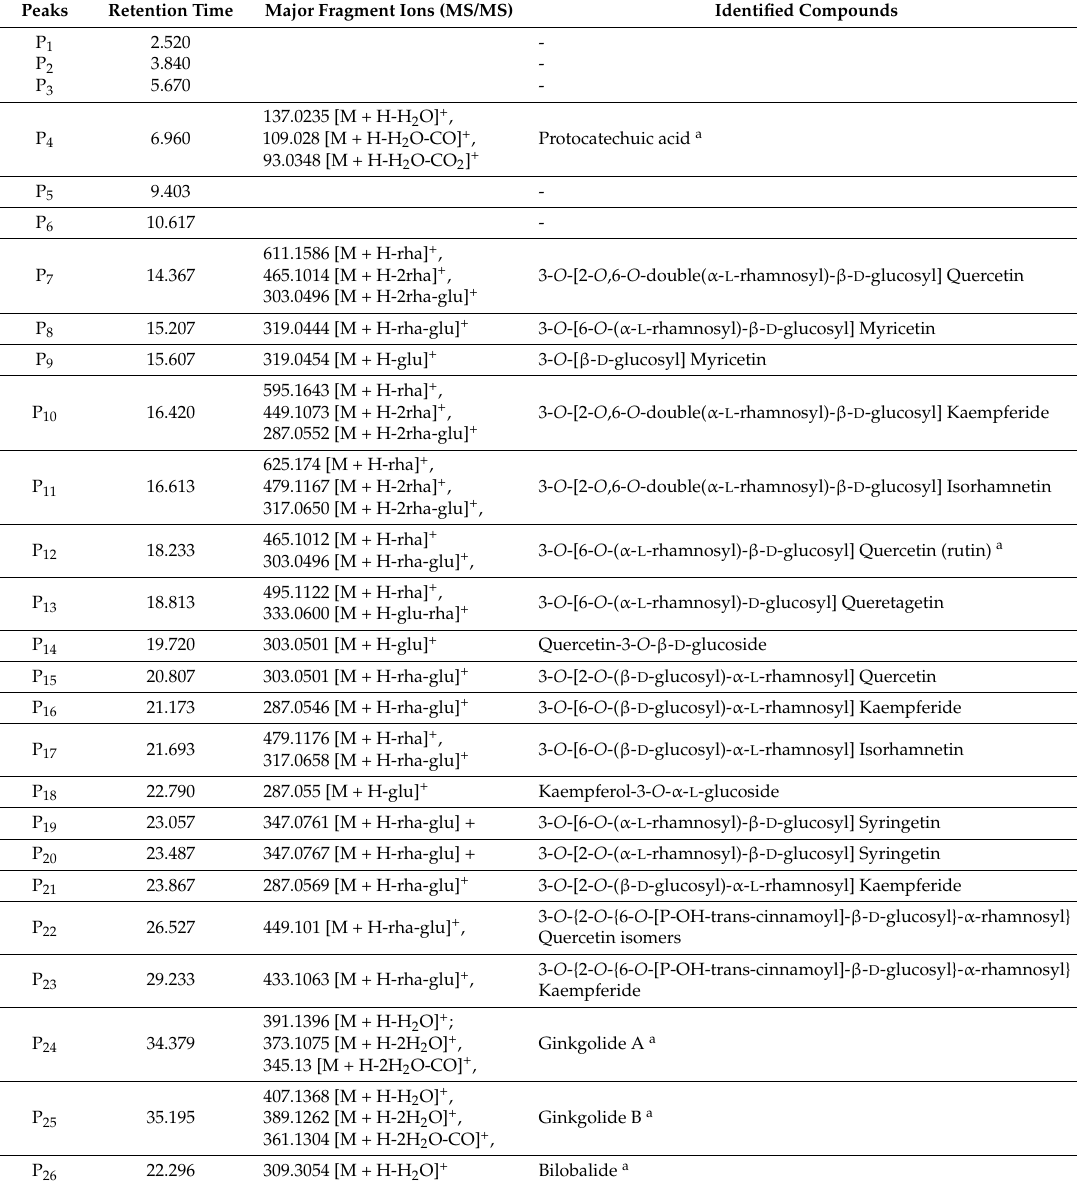
Table 1. Identification of 21 compounds in GBE HPLC fingerprint by UFLC-DAD-Q-TOF-MS/MS. Peaks Retention Time Major Fragment Ions (MS/MS) Identified